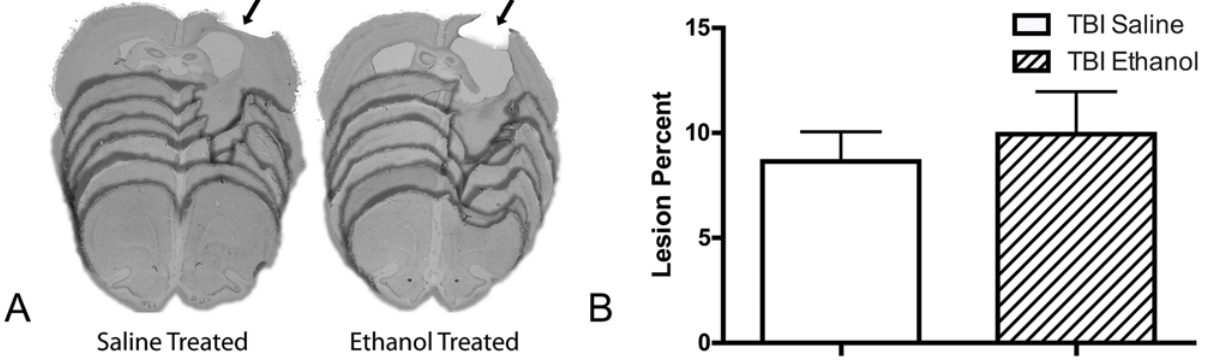
Fig 2. A. Representative nissl stained coronal sections of saline treated and ethanol treated seven weeks post traumatic brain injury. The arrows indicate the location of the lesion. B. Lesion size expressed as a percent of the unlesioned hemisphere. No significant difference was found between saline and ethanol treated animals p > .05 (unpaired t-test). Error bars denote the ± SEM.